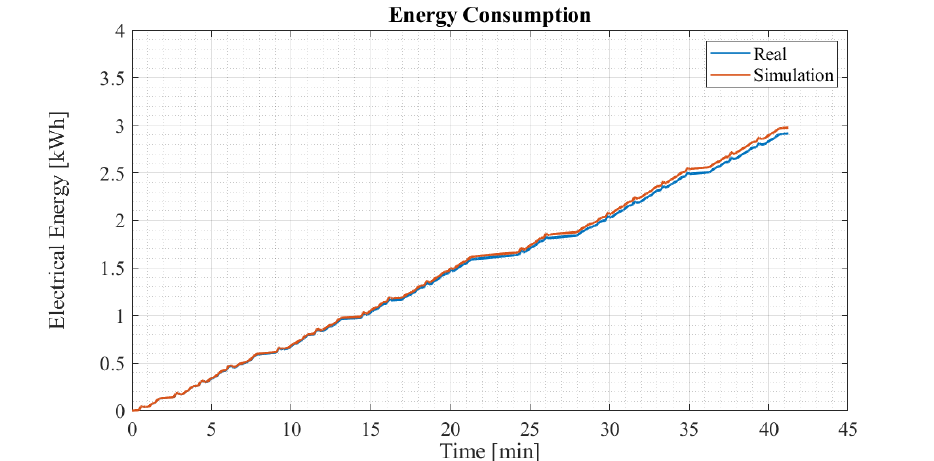
Figure 12. Simulated and real energy consumption of the railway